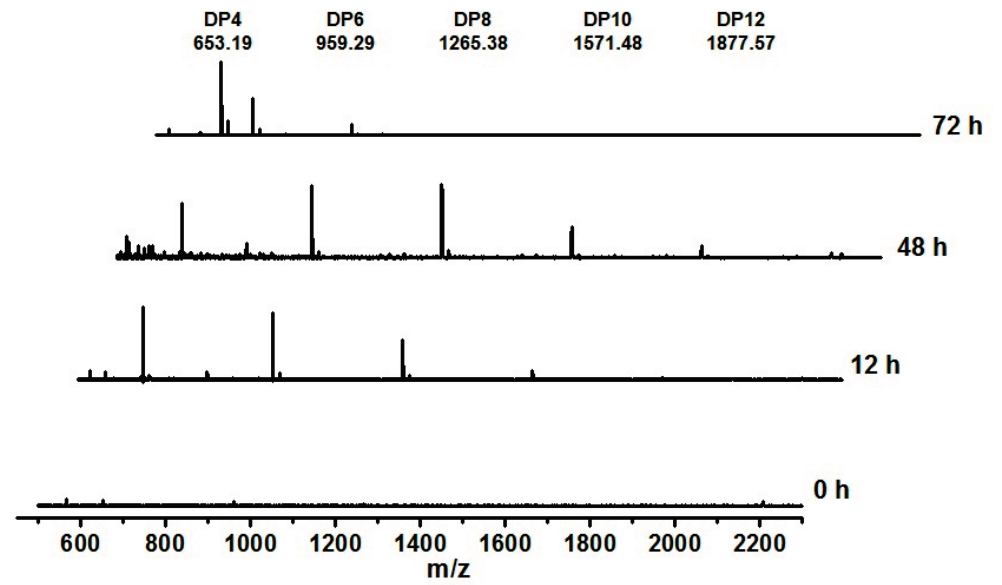
Figure 6. MALDI-TOF mass spectrum of the products at different time points of agarose hydrolysis by recombinant AgaA-FL. The sample was prepared by incubating recombinant AgaA with 0.3% ( w / v ) agarose at 40 °C for 72